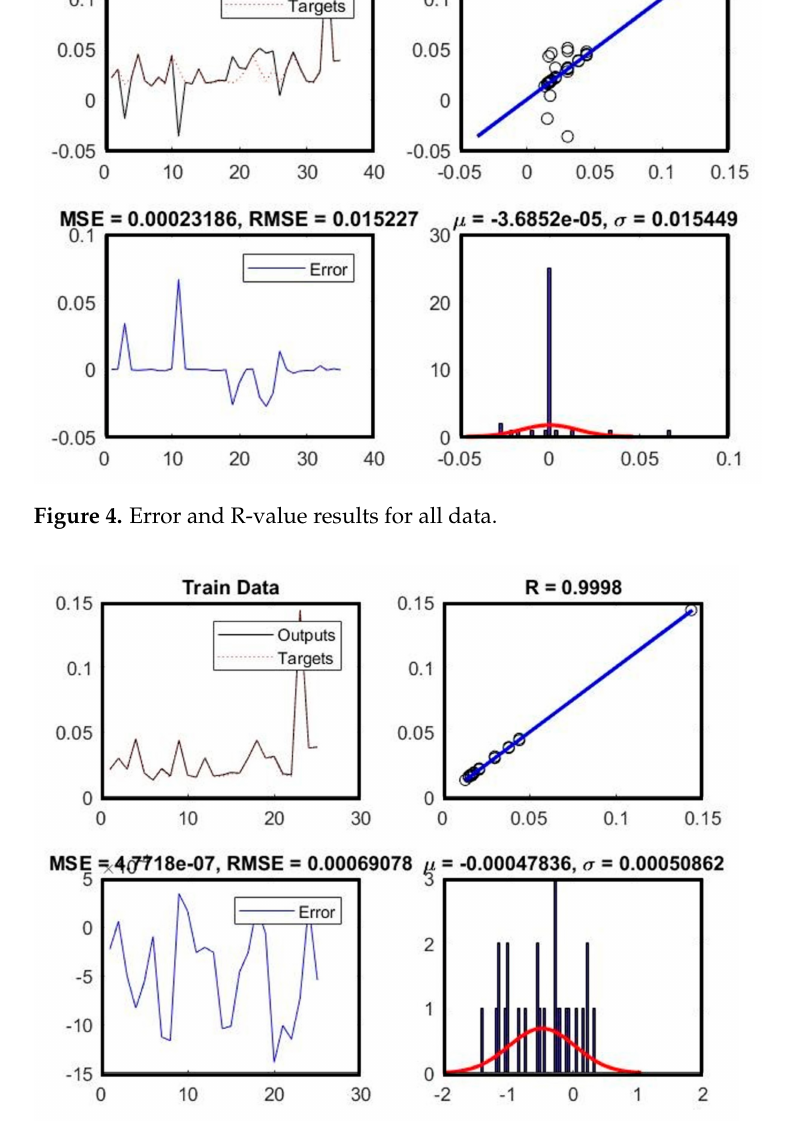
Figure 5. Error and R-value results for training